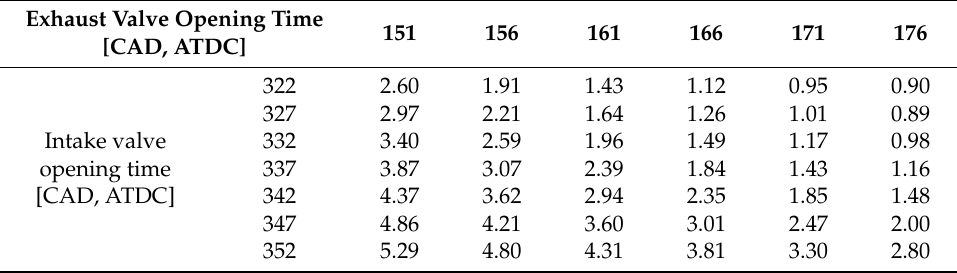
Table 4. Simulation results of residual gas fraction changes for each intake and exhaust valve timing at the excess air ratio of 1.25 with commercial one-dimensional (1D) simulation software (WAVE, Ricardo Inc.).